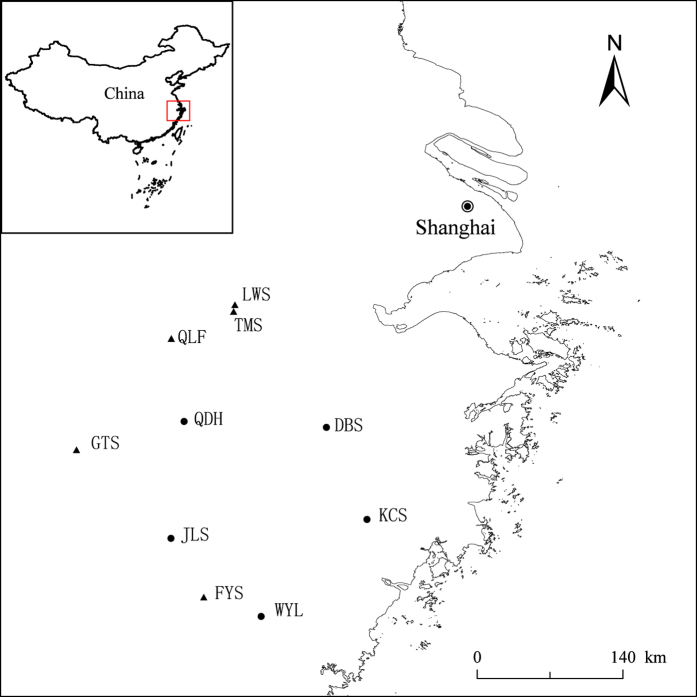
Location of the ten study forest plots in eastern China.Filled circles refer to disturbed forests, and filled triangles refer to undisturbed forests. The sites of DBS, FYS, GTS, JLS, KCS, LWS, QLF, WYL, TMS and QDH are located, respectively, in National Nature Reserve of Mount Dongbai, Mount Fengyang, Mount Gutian, Mount Jiulong, Mount Kuocang, Mount Longwang, Mount Qingliang, Wuyanling, Mount Tianmu, and Qiandaohu National Forest Park. Map was created with ArcGis, Version 10.0, http://www.arcgis.com/.